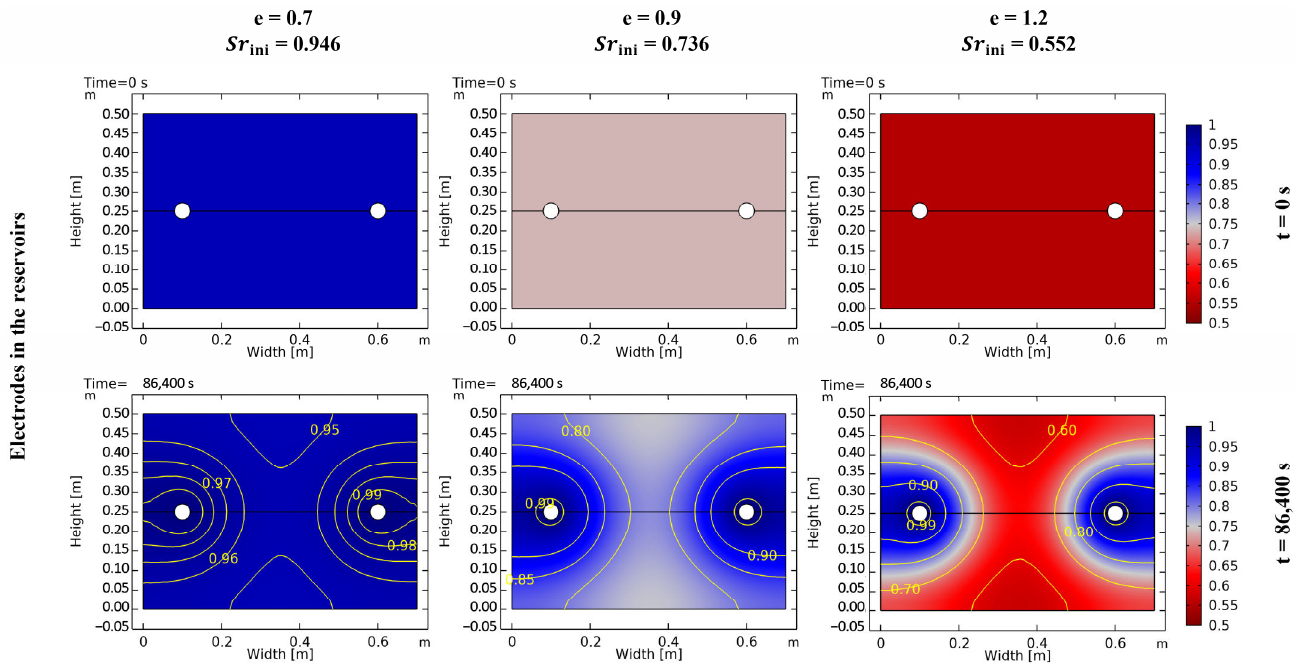
Figure 2. 2D maps of the degree of saturation evaluated at two times, 0 and 86,400 s (1 d), and three void ratios, 0.7, 0.9, and 1.2, when the electrodes were placed into the electrolyte reservoirs corresponding to the configuration presented in Figure 1a. Electric potential gradient: 1 Vcm − 1